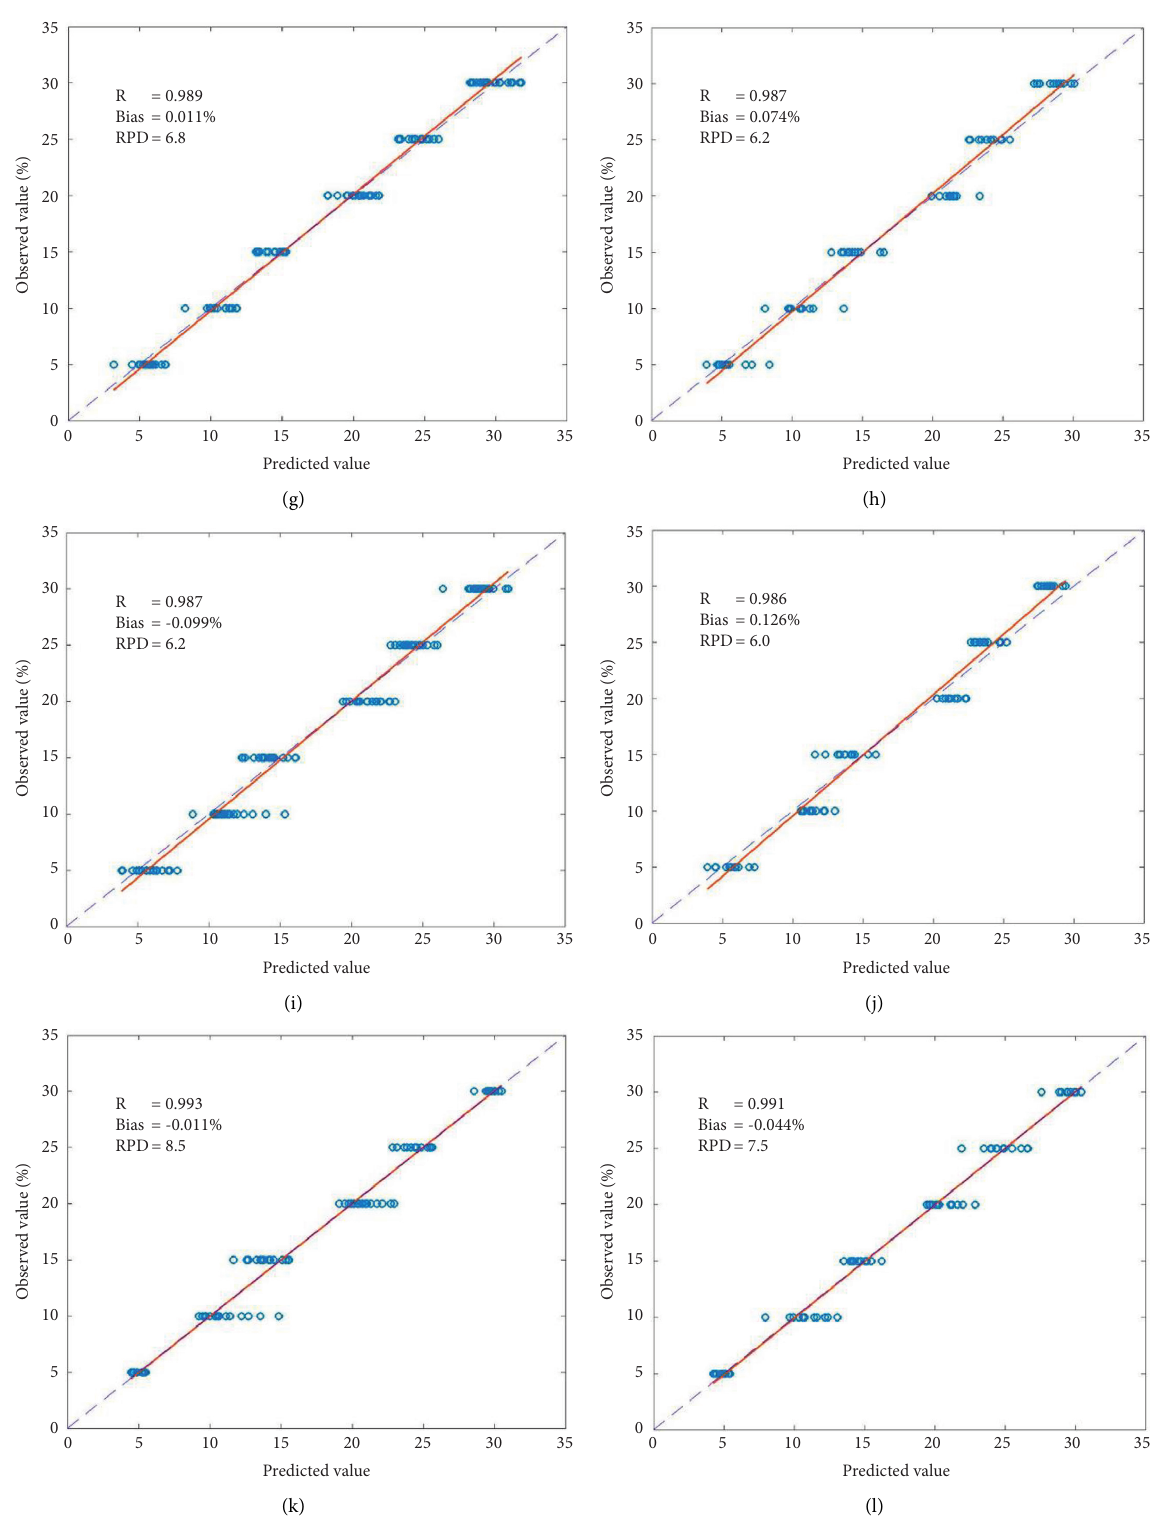
Figure 7: Correlation statistics between the observed values and predicted values: (a) validation set of PLSR, (b) testing set of PLSR, (c) validation set of SVR, (d) testing set of SVR, (e) validation set of PCA-PLSR, (f) testing set of PCA-PLSR, (g) validation set of PCA-SVR, (h) testing set of PCA-SVR, (i) validation set of MCUVE-PLSR, (j) testing set of MCUVE-PLSR, (k) validation set of MCUVE-SVR, and (l) testing set of